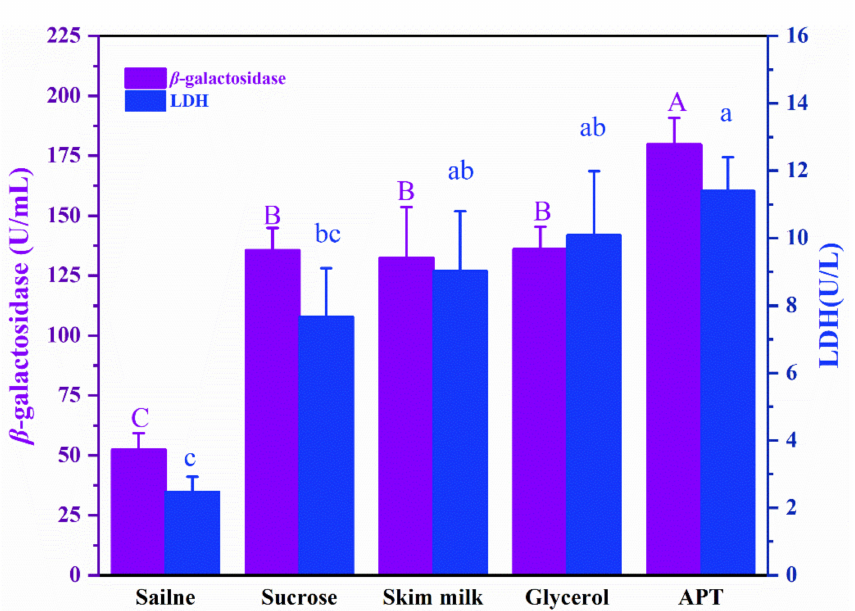
Figure 4. Effects of saline, positive cryoprotectants, and APT on β -galactosidase ( β -GAL) and lactic dehydrogenase (LDH) activities of L. rhamnosus frozen at − 20 ◦ C for 24 h. The bars in the same color with different capital letters or lowercase letters indicate significant differences ( p <